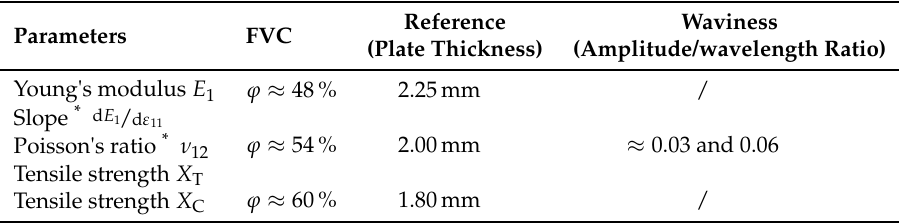
Table 3. Design of experiments in fiber